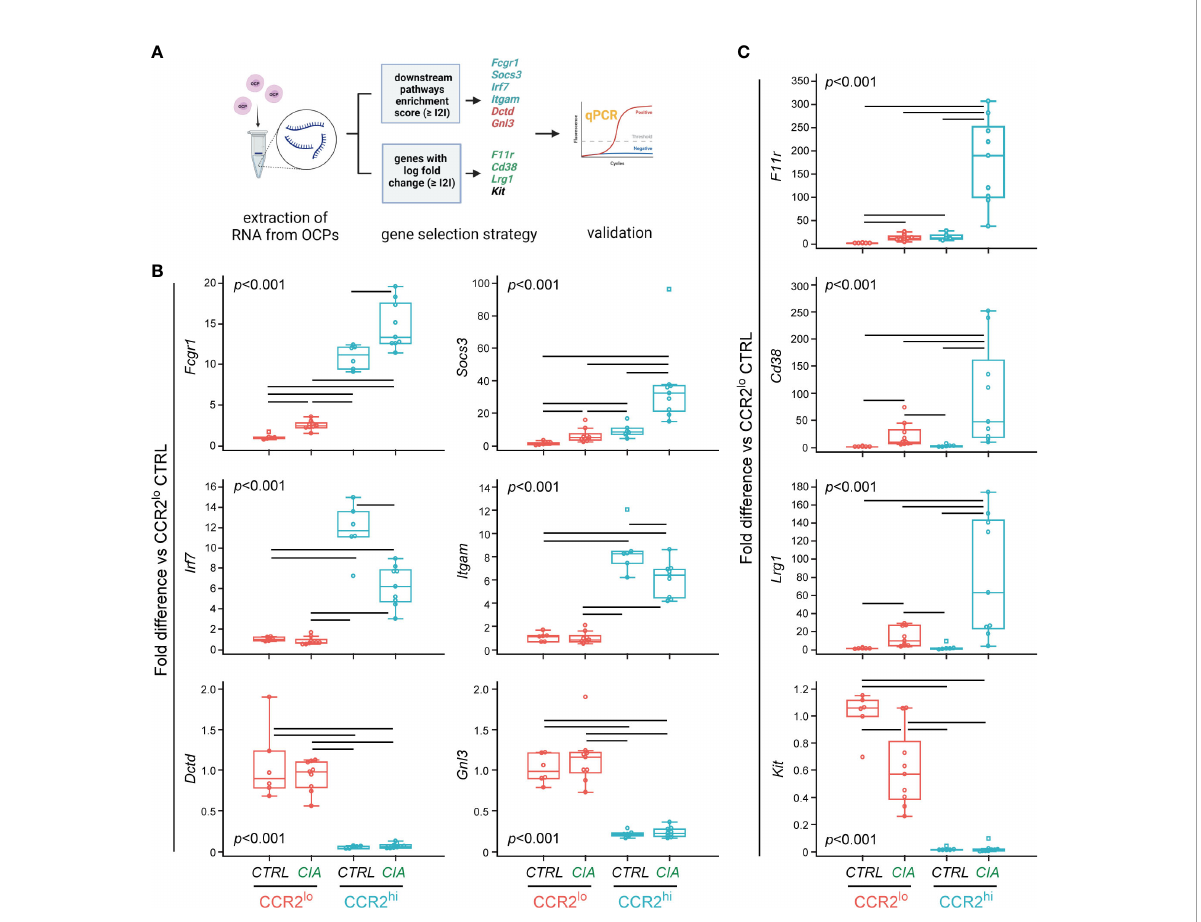
FIGURE 4 Validation of differentially expressed genes in osteoclast progenitor (OCP) subsets by qPCR. (A) Experimental design for qPCR validation of gene expression in sorted OCPs. RNA was extracted from sorted CCR2 lo and CCR2 hi OCP subsets from control (CTRL) mice and mice with collagen- induced arthritis (CIA), and reversely transcribed to cDNA. Genes were selected based on the enrichment score and based on the log fold change, and validated in CTRL and CIA groups (n=6 for CTRL, n=9 for CIA). Created with BioRender.com (B) qPCR analysis of genes within biological pathways signi fi cantly different between OCP subsets (CCR2 lo and CCR2 hi ), characterized as subset markers. (C) qPCR analysis of genes that have the most signi fi cant differential expression by intervention (CTRL or CIA), characterized as disease markers. (B, C) Gene expression was normalized to the Hmbs housekeeping gene and presented as fold difference relative to the calibrator sample (cDNA from CCR2 lo subset of CTRL, day 0). Individual values are presented; colored horizontal lines represent the median, boxes represent the interquartile range (IQR), whiskers represent 1.5 times the IQR, and squares represent outliers. Statistically signi fi cant difference (represented by black horizontal lines) was determined at p<0.05, Kruskal – Wallis test followed by Conover test for group-to-group